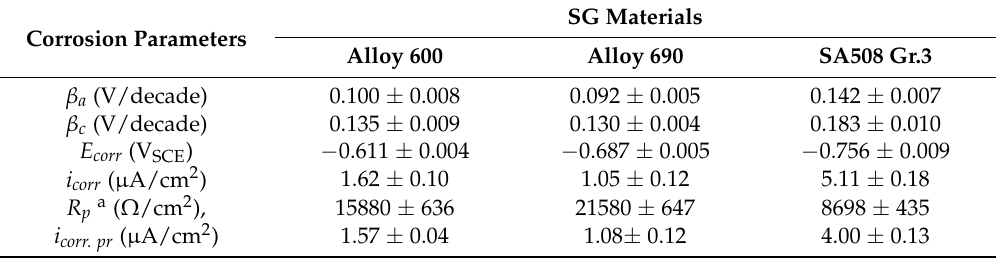
resistance R p , and corrosion current density i corr. pr obtained from polarization resistance